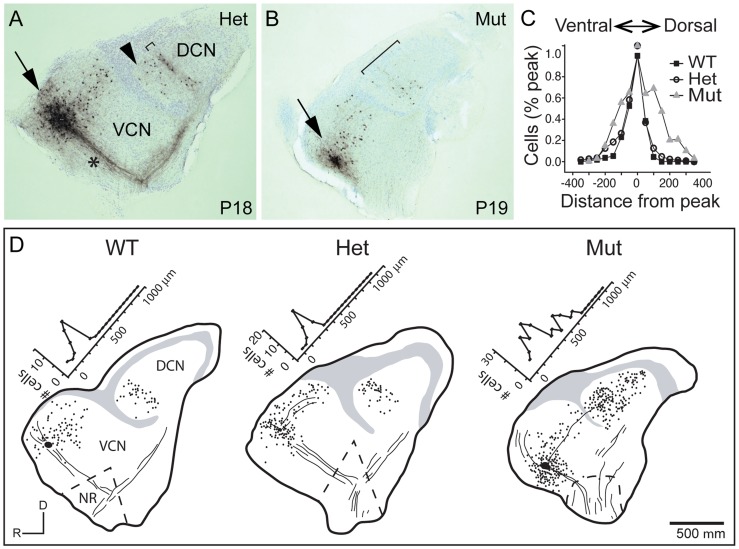
Tonotopy of TV neuron projections from the DCN to the aVCN is also blurred.(A) Photomicrograph of a section of a parasagittal slice from a P18 heterozygote control animal with a biocytin injection into the aVCN (arrow). Biocytin labeled processes and cell bodies of neurons that passed through the injection site. Labeled processes included auditory nerve fibers (asterisk), the axons and terminals of TV cells whose cell bodies lie in the DCN (bracket), and the dendrites and local axonal collaterals of T stellate and D stellate cells whose cell bodies formed a halo around the injection site. Labeled TV cells clustered in a band (bracket) among terminals of auditory nerve fibers that were labeled by the same injection, showing that the TV cells lie in the same isofrequency lamina as their VCN targets. A few TV cells whose axons crossed the injection site on their way to more ventral regions were labeled ventral to (arrowhead) the labeled band of TV cells. No cell bodies were labeled in the DCN dorsal to the labeled band, indicative of the sharp tonotopic organization of the projection. (B) A similar injection of biocytin into the aVCN of a P19 Npr2 mutant animal labeled a more diffuse bundle of auditory nerve fibers, a halo of neurons in the aVCN, and TV cells that were more scattered than in the heterozygote (bracket). (C) To compare the distribution of labeled neurons between control and mutant animals, peaks of distributions were lined up and normalized. In WT (n = 6 slices, 258 cells) and Hets (n = 20 slices, 914 cells), labeled cells were distributed in a sharp band, with no labeled cells more than 150 µm from the peak on the dorsal side. Since no clear bands were observed in Npr2 mutants (Mut) (n = 11 slices, 858 cells), histograms were aligned along their medians, at which half of the labeled cells lay more dorsal and half more ventral. The bands were sharp in both WT and Het animals, but were significantly broader in Npr2 mutant mice (P<0.001, ANOVA). No differences were detected over the age range examined between P14 and P26. (D) Examples of reconstructed slices, with labeled cells marked with dots, gray regions denoting areas containing granule cells in the largest section, and lines indicating the location of some of the labeled fibers. Numbers of labeled TV cell bodies were plotted as a function of distance along the tonotopic axis of the DCN, as illustrated. Scale bar, 500 µm.